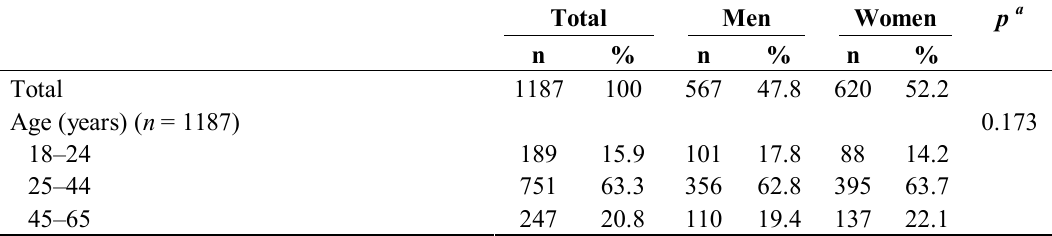
Table 1. Socio-demographic and migration-related characteristics by